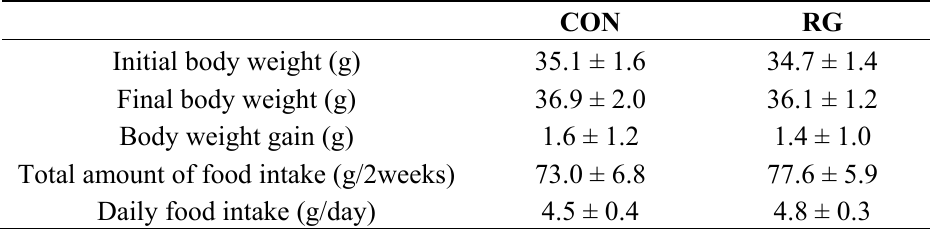
Table 2. The change of body weight, food